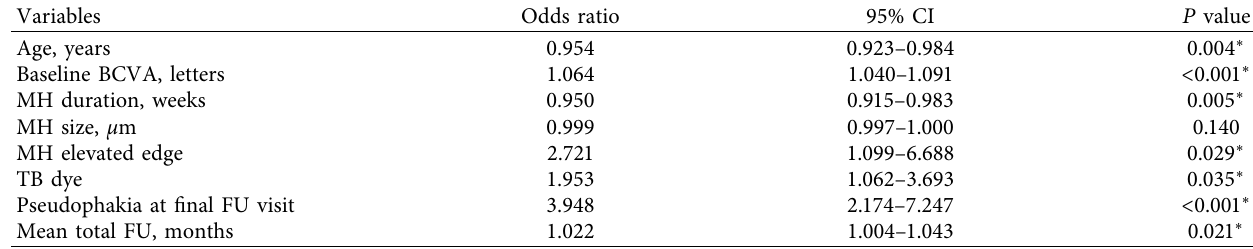
Table 3: Multiple logistic regression for final VA ≥ 70 ETDRS letters outcome.